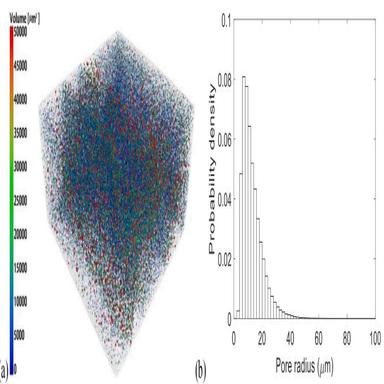
Pore information obtained by XCT experiment: (a) 3D visualization of all pore, (b) the distribution of pore size.